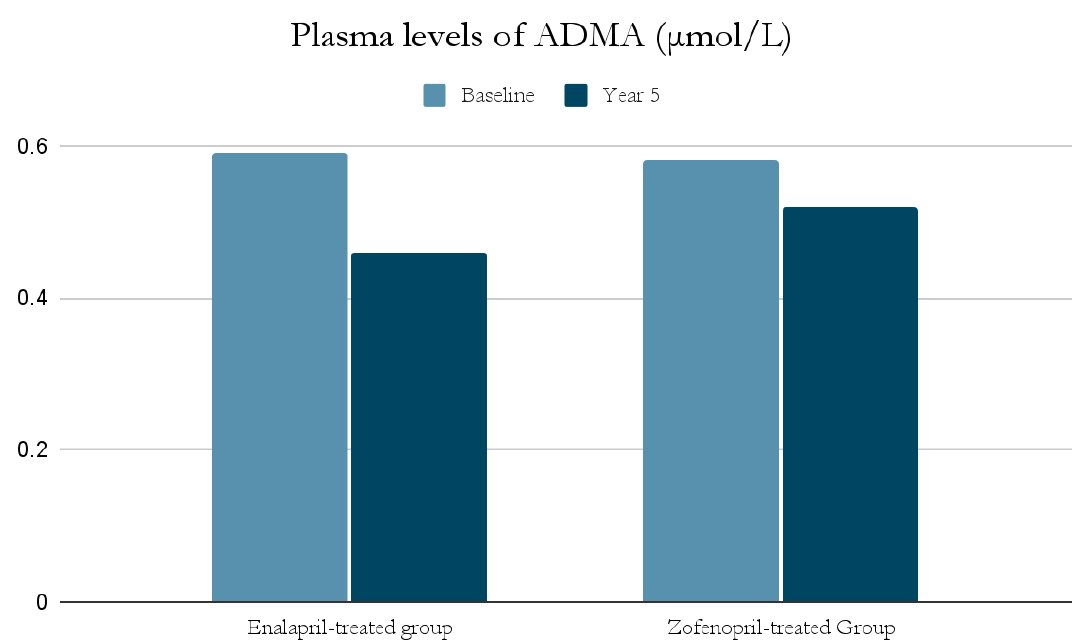
Figure 3. Comparison of plasma levels of ADMA ( µ mol/L) at baseline and at year 5 in the enalapril and zofenopril groups. Newly diagnosed hypertensive patients (SBP > 160 mm Hg and/or DBP > 95 mm Hg) participated in the study. They were randomly assigned to receive enalapril (20 mg/d, n = 24) or zofenopril (30 mg/d, n = 24). Exclusion factors were additional risk factors for coronary artery disease or a history of ischemic events, as well as prior or concurrent therapy with ACE-I, antiplatelet agents or anticoagulants [37].